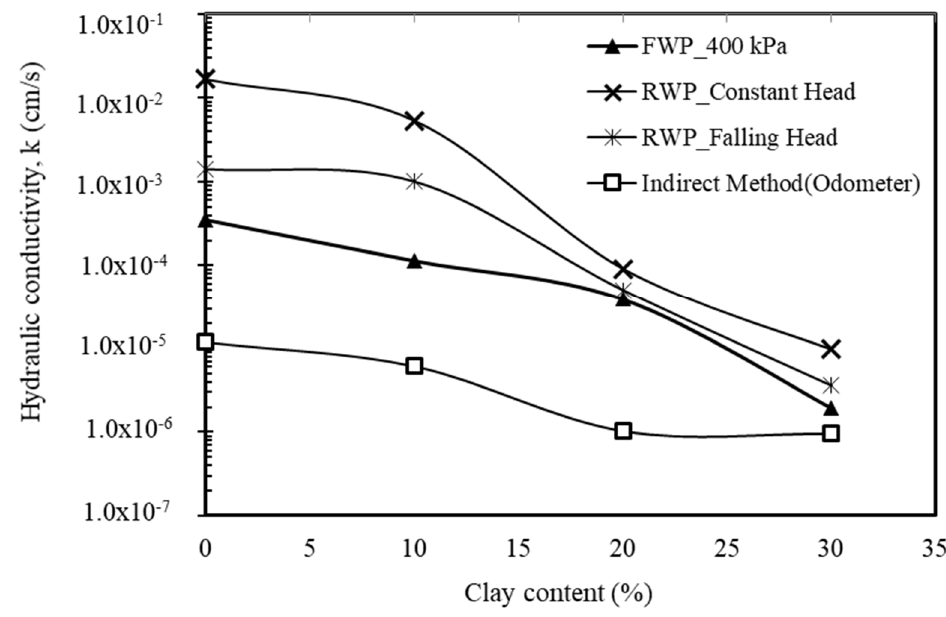
Figure 9. Hydraulic conductivity for a flexible wall at 400 kPa stress compared to other methods.